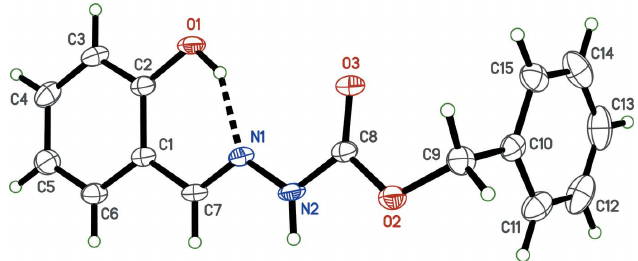
Table 2 Hydrogen-bond geometry (A˚ , (cid:3) ) for II .